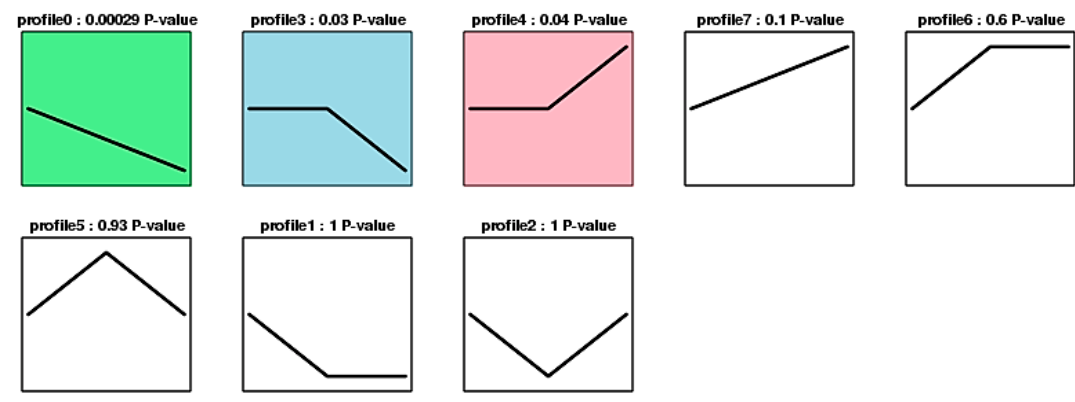
Figure 6. Cluster analysis of DAPs in AS and AF during different stages (UNP, BNP, and TNP). Based on fold changes of 1.2, the 127 DAPs could be divided into eight groups (profile 0 to 7) with correlated abundance patterns. The green represent profile 0; the blue represent profile 3; the red represent profile 4, were significantly different.